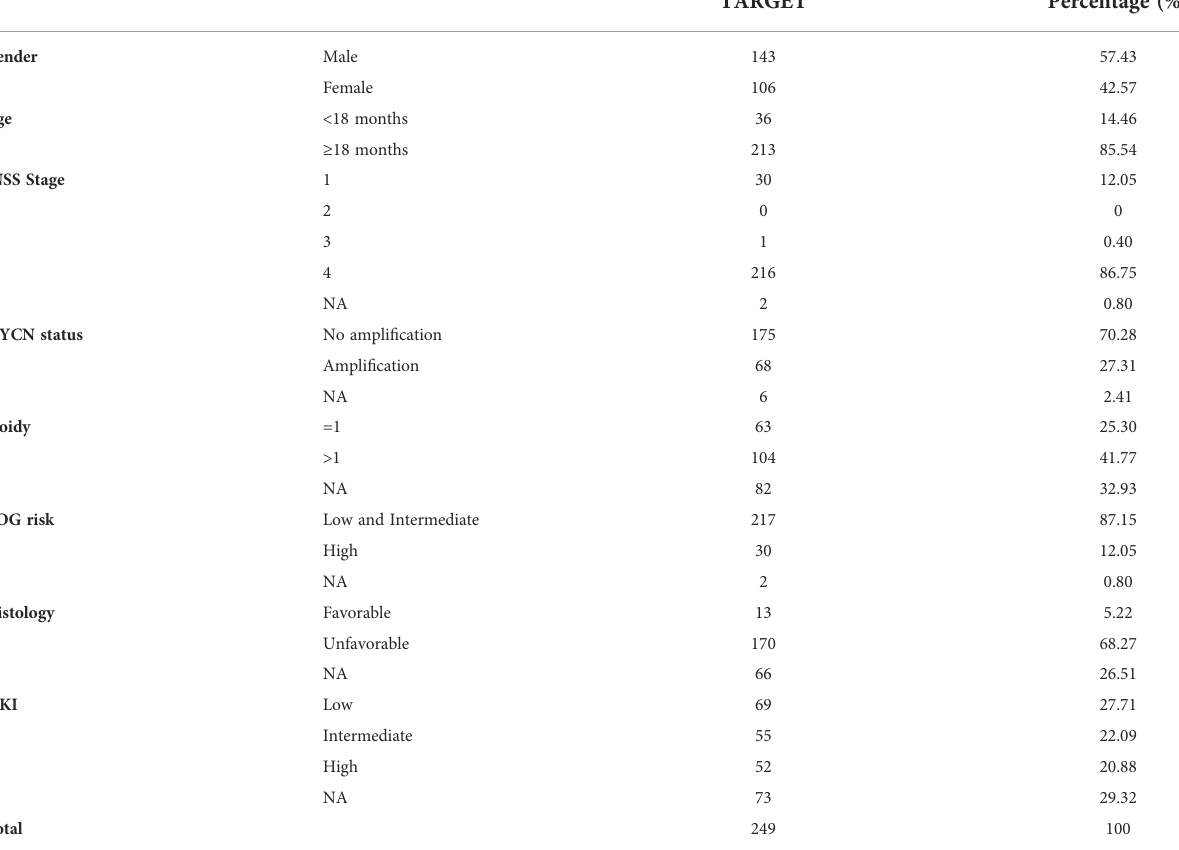
TABLE 1 Demographic/clinicopathological features of the TARGET dataset used for this